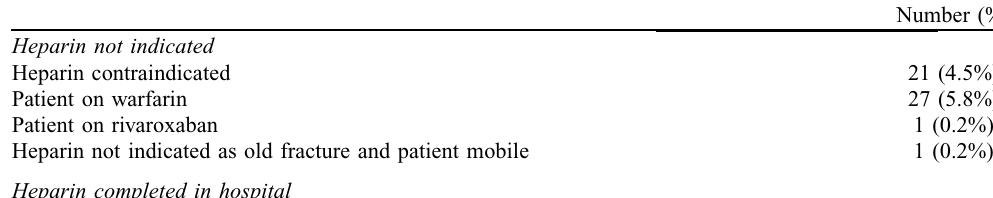
Table 1. Details of how patients completed their heparin